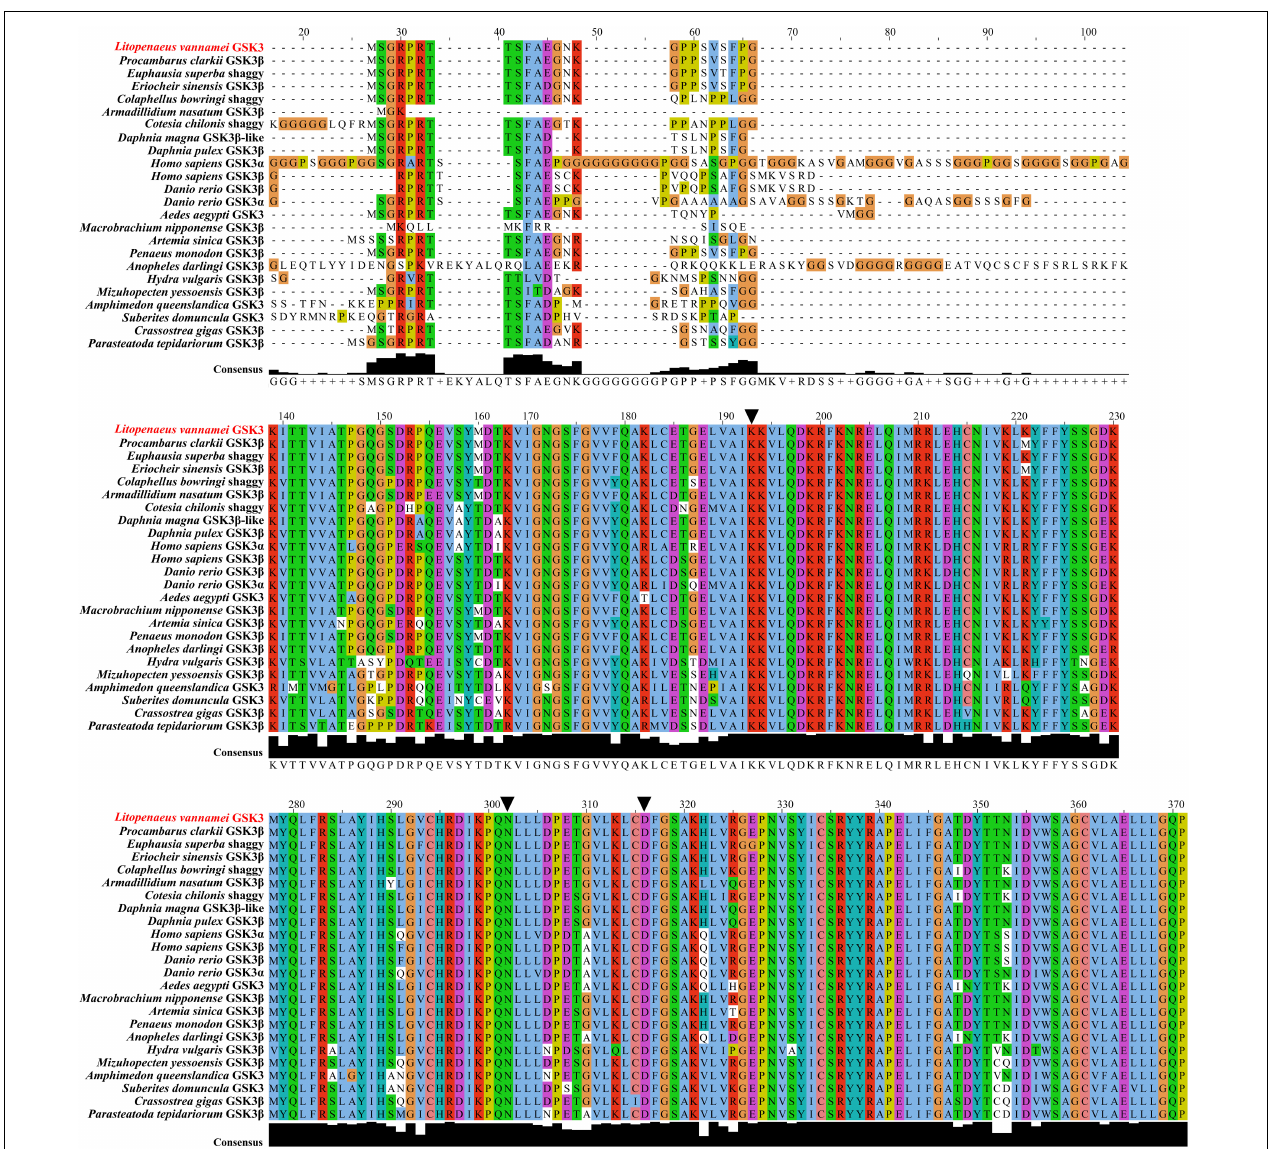
FIGURE 2 | Multiple sequence alignment of the GSK3 protein sequences. The results of multiple sequence alignment were visualized and ornamented by the Jalview. The black triangles ( (cid:72) ) represent those sites in the ATP-binding